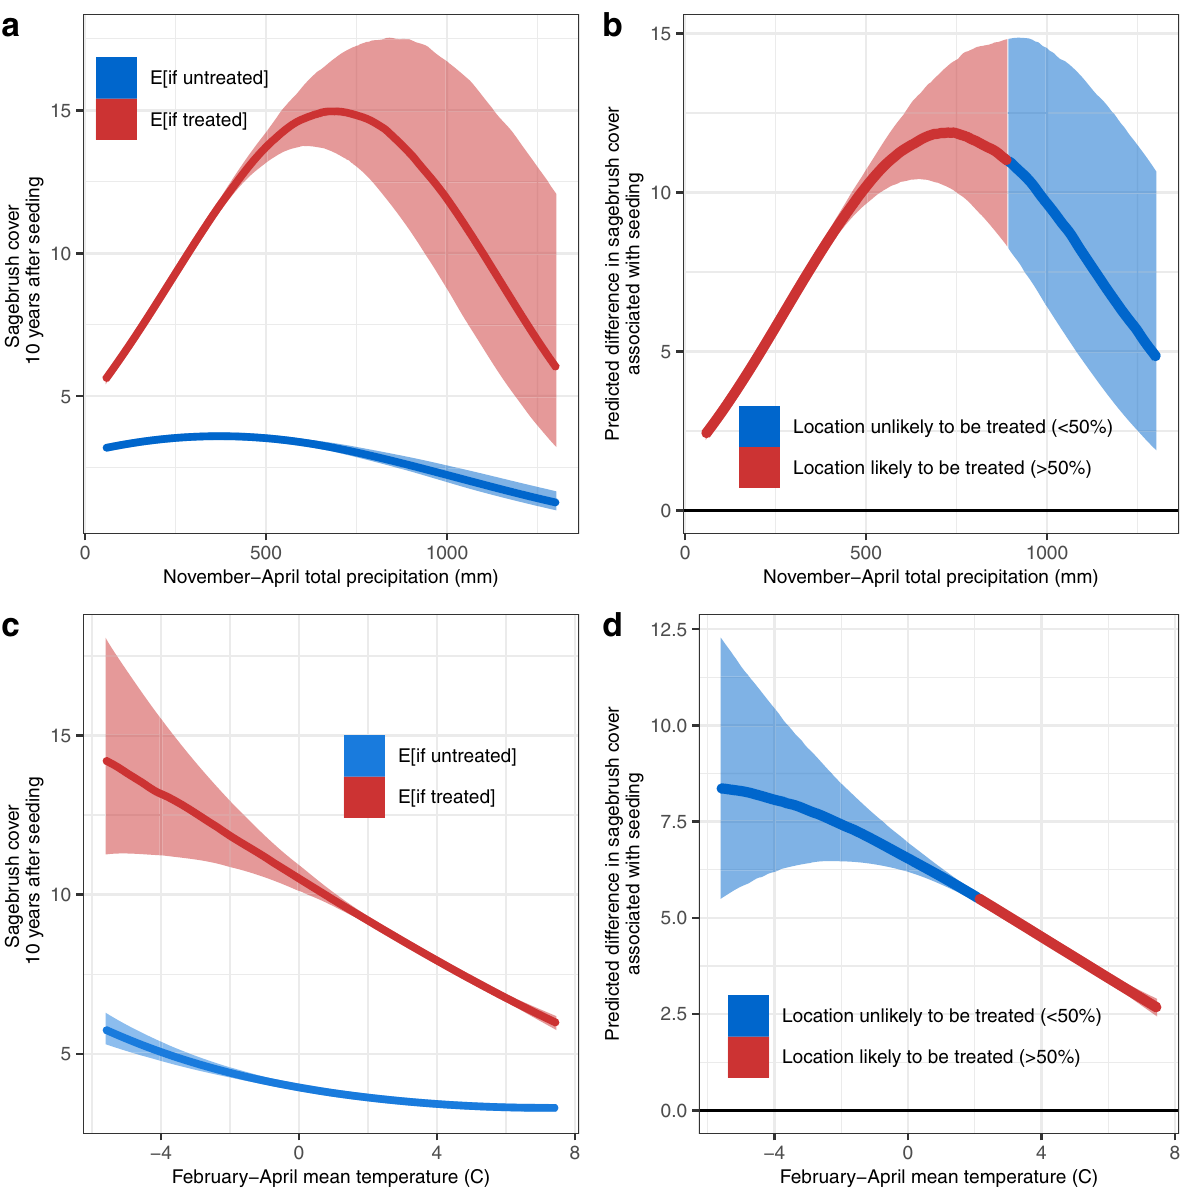
Fig. 5 Variation in the effects of seeding treatments across climatic gradients. Panels show sagebrush percent cover (%) 10 years following fi re (shown for the Central Basin and Range Ecoregion), along gradients of ( a , b ) November-April total precipitation (30-year average) and ( c , d ) February-April mean temperature (30-year average). Panels on the left ( a , c ) illustrate the expected ( “ E ” ) of sagebrush cover for sites in the treated group, if they were to either receive or not receive treatment (median expectations, shown with 50% credible intervals). Panels on the right ( b , d ) illustrate the difference in sagebrush recovery observed when treatment is applied (median expectations, shown with 50% credible intervals). Positive values (above the solid line at 0) indicate gains associated with reseeding; line color indicates whether restoration is likely (>50% probability of occurrence) or unlikely (<50%) to occur at given precipitation ( b ) or temperature ( d ) conditions, based on the model of treatment probability (see Figs. 2, 3). Posterior parameter estimates for all covariates included in the associated model (n = 20,000 locations) can be found in Supplementary Fig.